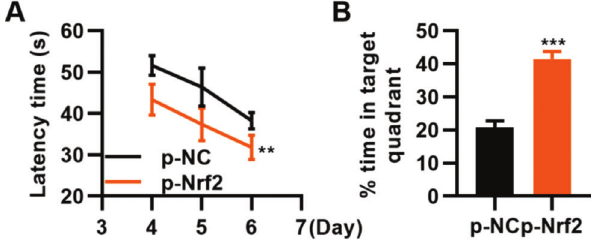
Figure 6 - Transfection of p-Nrf2 plasmid enhances the ability of traumatic brain injury (TBI) rats in spatial learning and memory. A, Results of the Morris water maze indicated that p-Nrf2 transfection shortened the escape latency of TBI rats; B, Rats in the p-Nrf2 group had an increased percentage of time spent in the targeted quadrant. ** p o 0.01, *** p o 0.001. Chi-squared